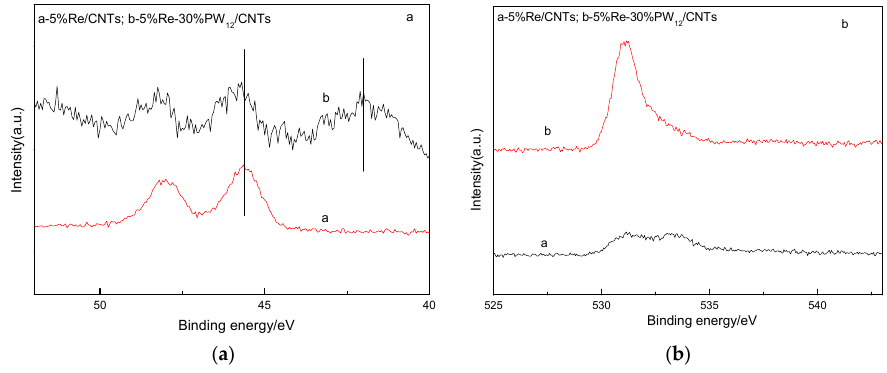
Figure 5. Re 4f ( a ) and O1s; ( b ) XPS spectra for 5%Re/CNTs and 5%Re ‐ 30%PW 12 /CNTs.